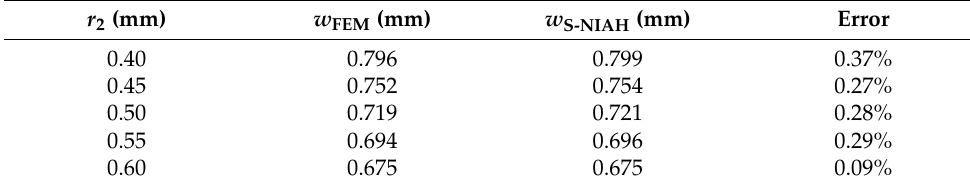
Table 6. Deflections and errors at mid-point under different r 2 .